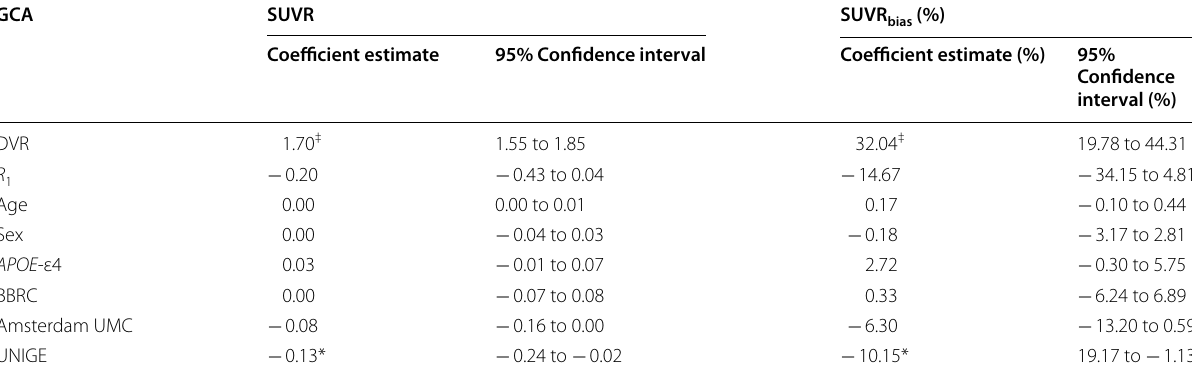
Females, APOE -ε4 non-carriers and centre UEDIN were used as reference groups GCA: global cortical average, * p < 0.05, † p < 0.01, ‡ p < 0.001